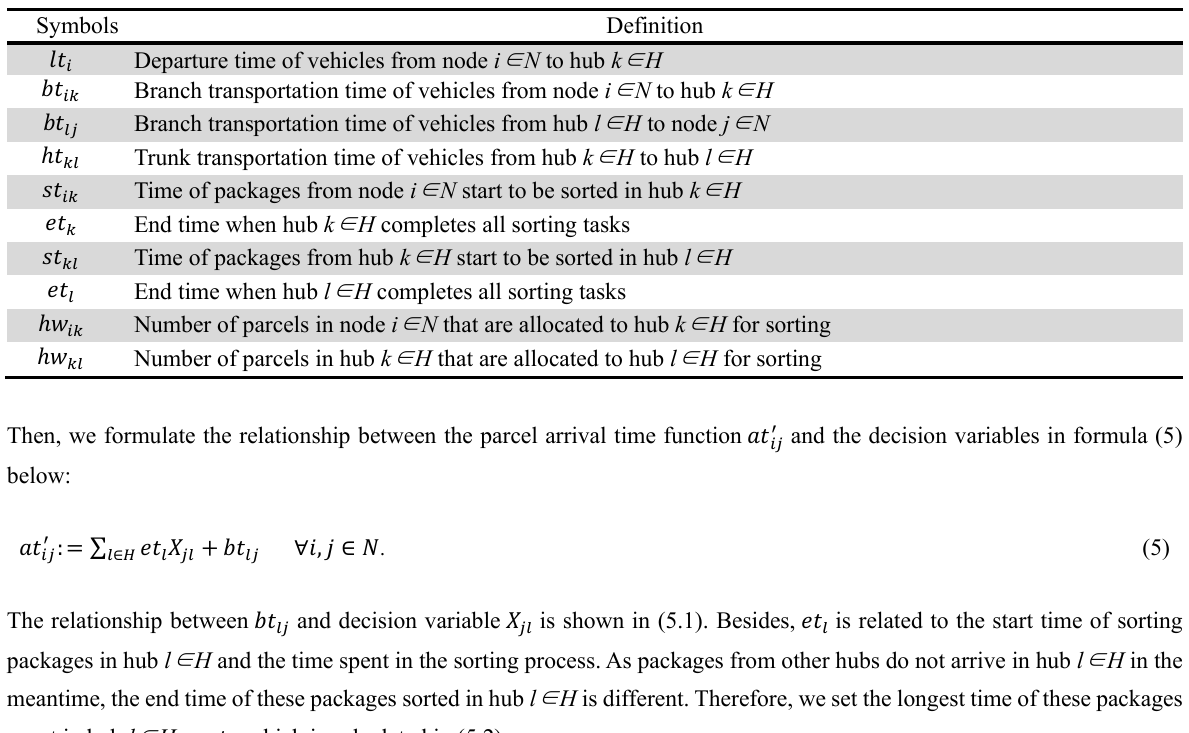
Definition of time in business